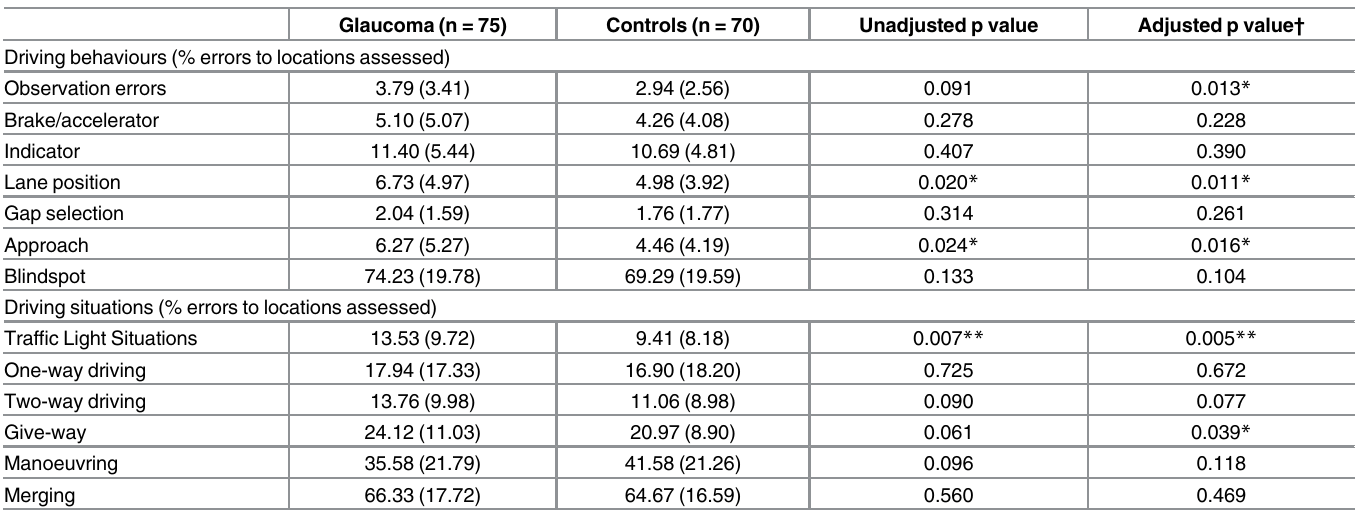
Table 4. Specific error types and locations of errors made as a function of